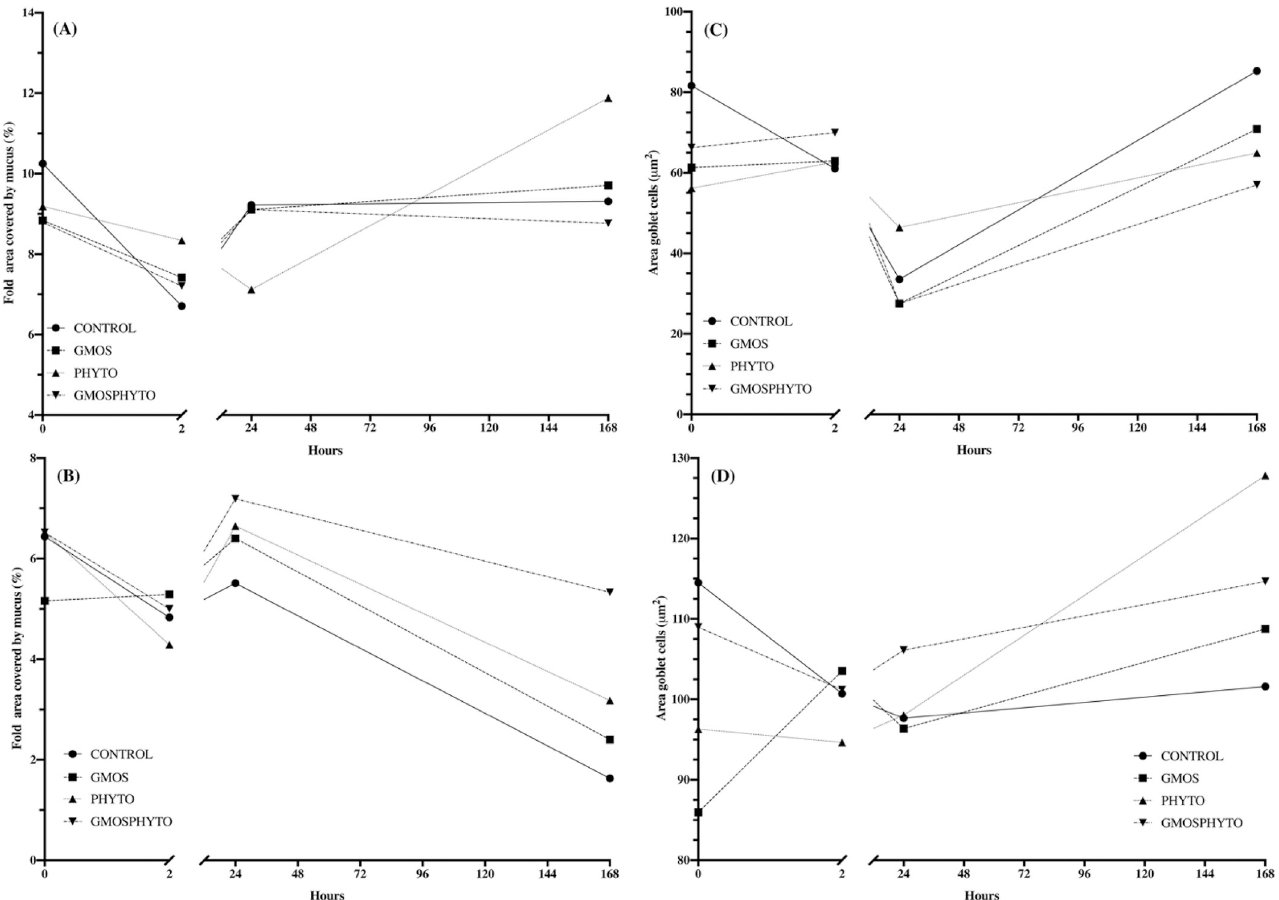
Fig 10. Time course study of European sea bass ( Dicentrarchus labrax ) posterior and rectum gut fold area percentage covered by goblet cells and goblet cell area ( μ m 2 ) during the 7 days of the challenge test ( V . anguillarum intestinal infection + stress by confinement). Functional low FM and FO diets were fed for 70 days (63 feeding+7days of challenge test). (A) Posterior gut fold area percentage covered by goblet cells during the challenge test. Observe the different pattern of response presented by fish fed PHYTO diet, which shows a trend for a higher percentage of mucus coverage after 2h of challenge, which is reduced after 24h, and clearly recovered after 7 days of challenge test compared to fish fed other dietary treatments. (B) Rectum fold area percentage covered by goblet cells during the challenge test. Observe the different pattern of response presented by fish fed GMOSPHYTO diet, which show a higher percentage of mucus coverage 24h and 7 days (p < 0.05) after challenged compared to fish fed control diet. Two-way ANOVA analyses showed an increased percentage of fold covered by mucus for PHYTO dietary supplementation in low FM and FO diets at the end of the challenge test (F = 12.56; p = 0.012). (C)Posterior gut goblet cells area ( μ m 2 ) during the challenge test. Observe how initial patterns are recovered after 7 days of challenge test for all dietary treatments, fish fed control diet having larger goblet cells (p < 0.05) than fish fed PHYTO diet. However, 24h post challenge fish fed PHYTO diet presented larger (p < 0.05) goblet cells than fish fed GMOS and GMOSPHYTO diets. Two-way ANOVA analyses associated a significant reduction in goblet cell size to dietary PHYTO supplementation in low FM and FO diets for 63 days (t = 0 hours; F = 3.95; p = 0.05) as well as at the end of the challenge test (t = 168 hours; F = 6.94; p = 0.030). On the other hand, PHYTO dietary supplementation in low FM and FO diets was associated with an increase in goblet cell size (F = 7.67; p = 0.013) 24h after the challenge. GMOS supplementation was associated with a reduction in goblet cell size 24h (t = 24 hours; F = 7.676; p = 0.013) and 7 days after the challenge (t = 168 hours; F = 16.26; p = 0.004). (D) Rectum goblet cell area ( μ m 2 ) during the challenge test. Observe how fish fed PHYTO diet presented a larger (p < 0.05) goblet cell area than fish fed control diet at the end of the challenge test (t = 168h). C (control diet), GMOS (5000 ppm galactomannan oligosaccharides), PHYTO (200ppm